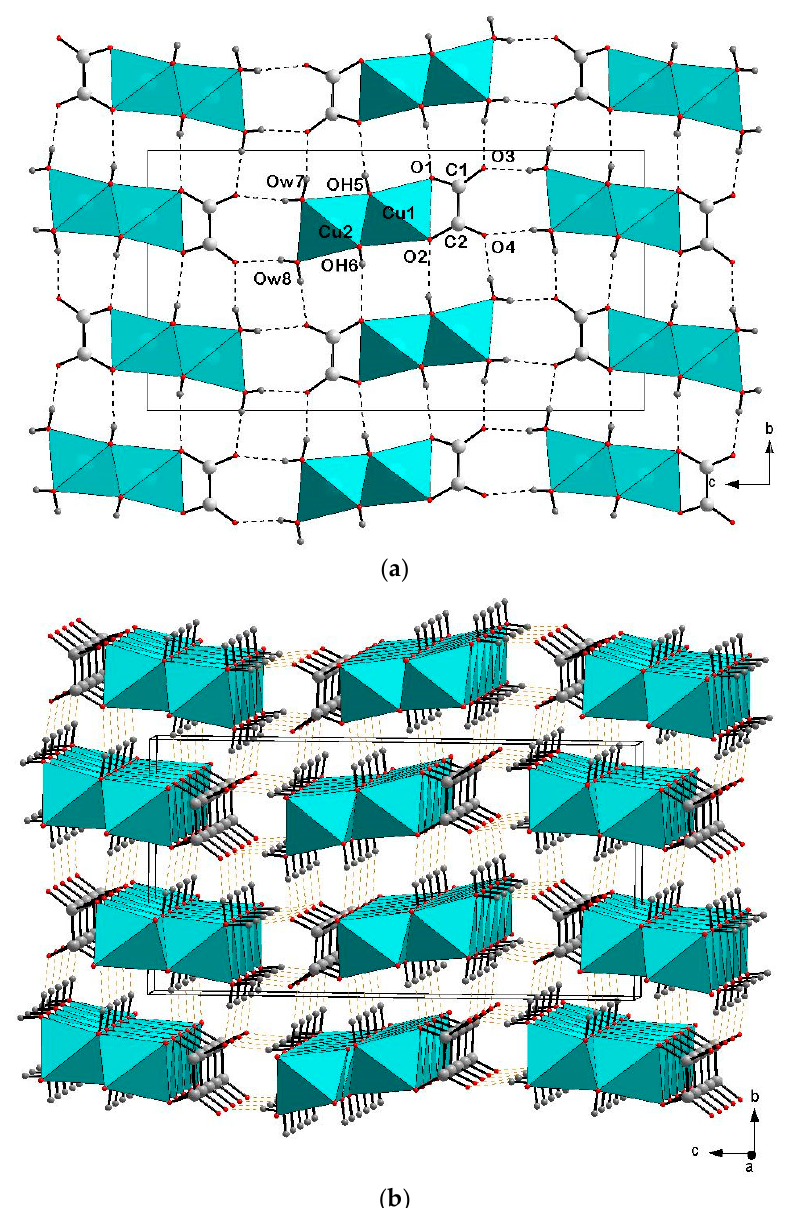
Figure 3. Projection along [100] with atoms labelling ( a ) and perspective view ( b ) of the crystal structure of fiemmeite with hydrogen bonds represented as dashed lines.